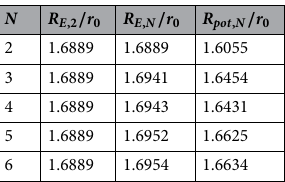
Table 2. Classical turning points R E ,2 , R B , N and R pot , N , defined by Eqs. (4–6) in N -body system in a dipolar bilayer with h / r 0 = 1.2